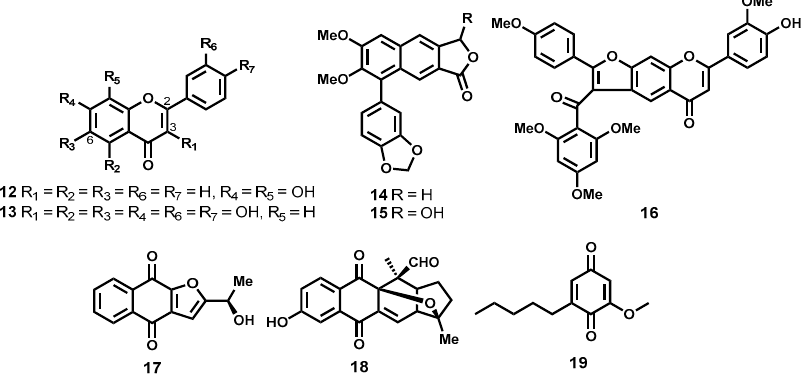
Figure 3. Trypanocidal phenolic and quinone derivatives.